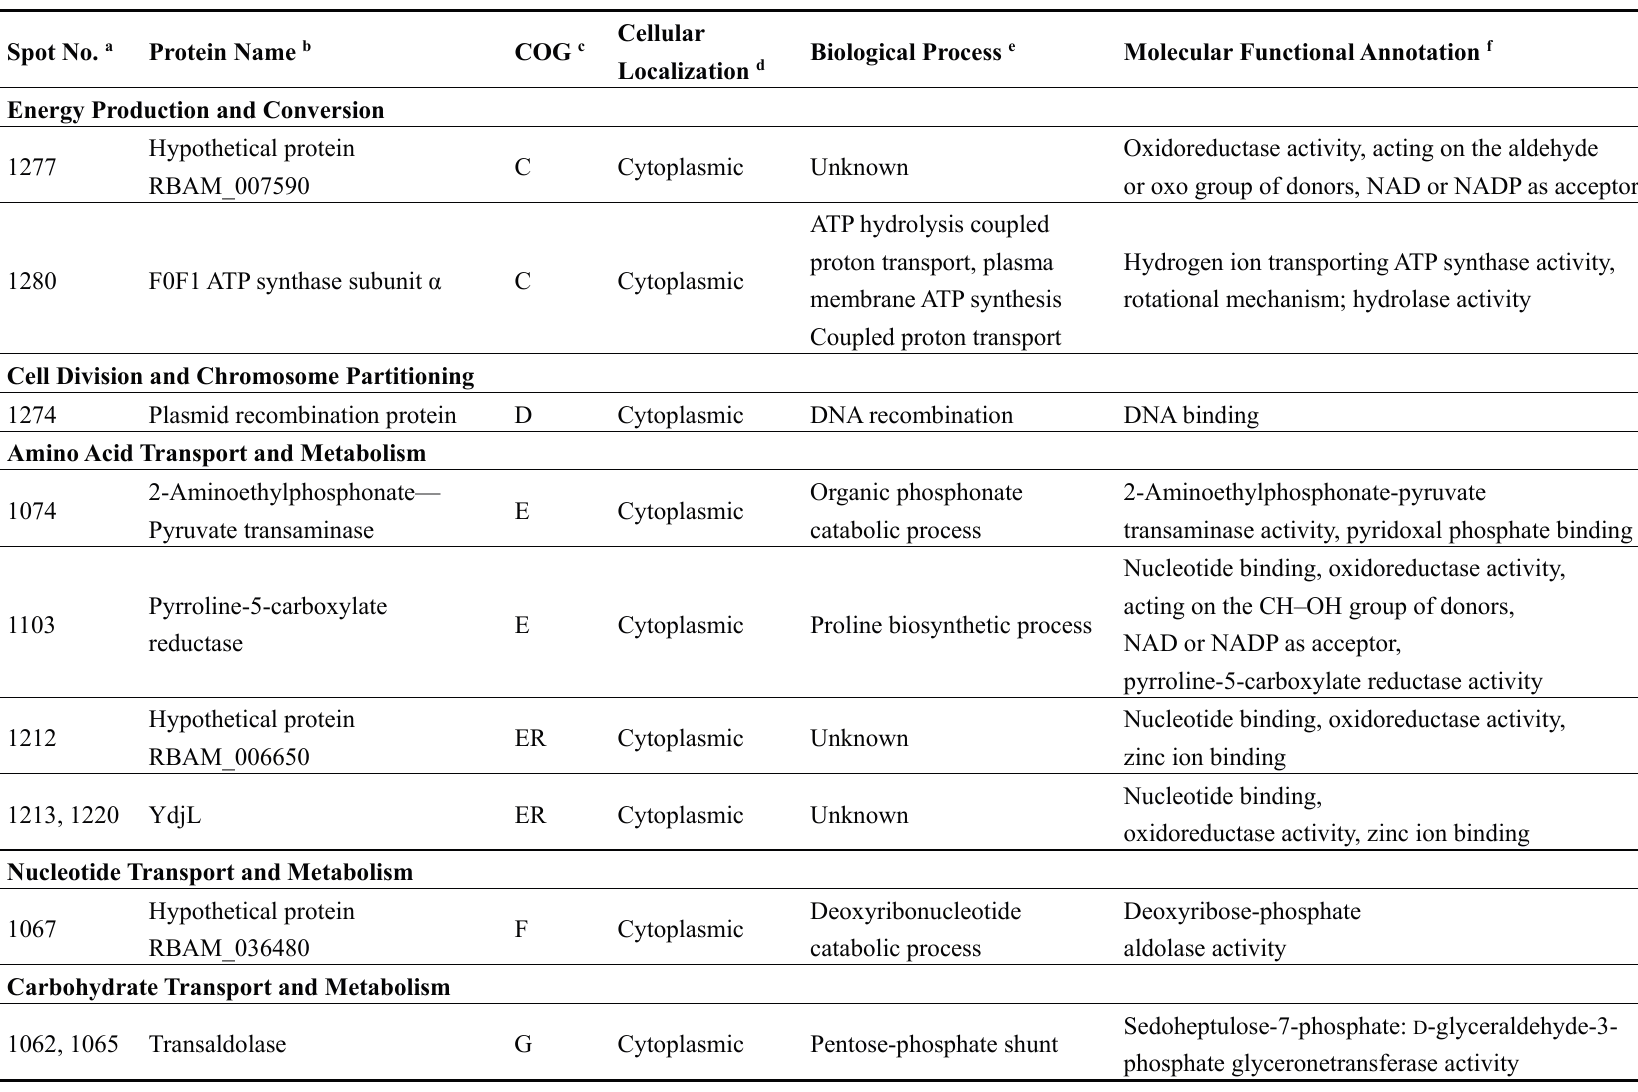
Table 2. Cellular localization and function of differentially regulated cellular proteins (>2-fold change in expression) of Bacillus amyloliquefaciens FMB38. Spot No. a Protein Name b COG